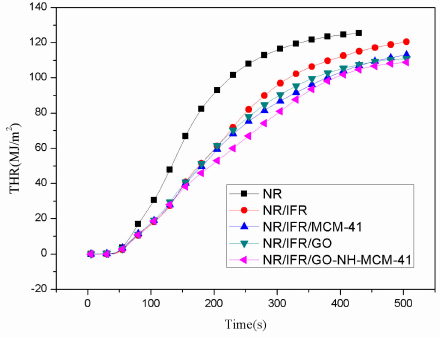
Figure 3. Total heat release (THR) curves of FRNR composites.